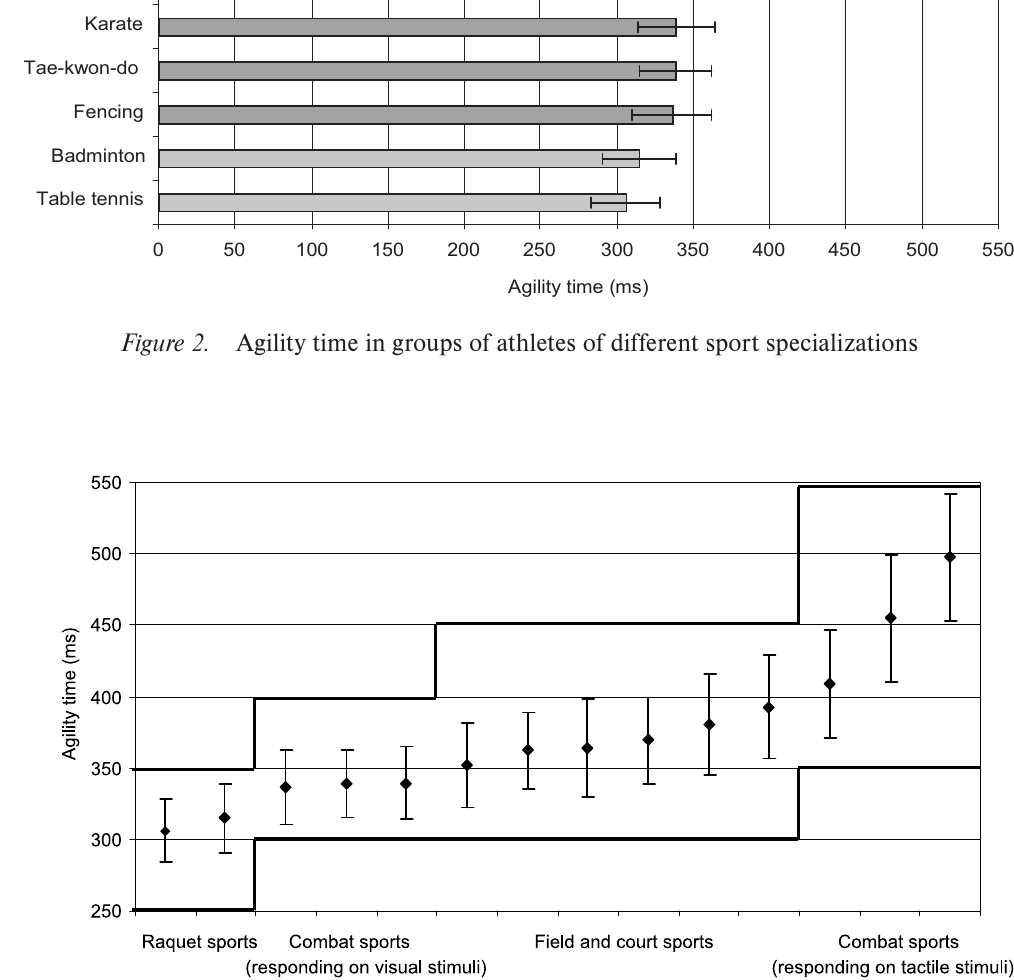
Figure 3. Agility time (± SD) in different sports divided in four basic